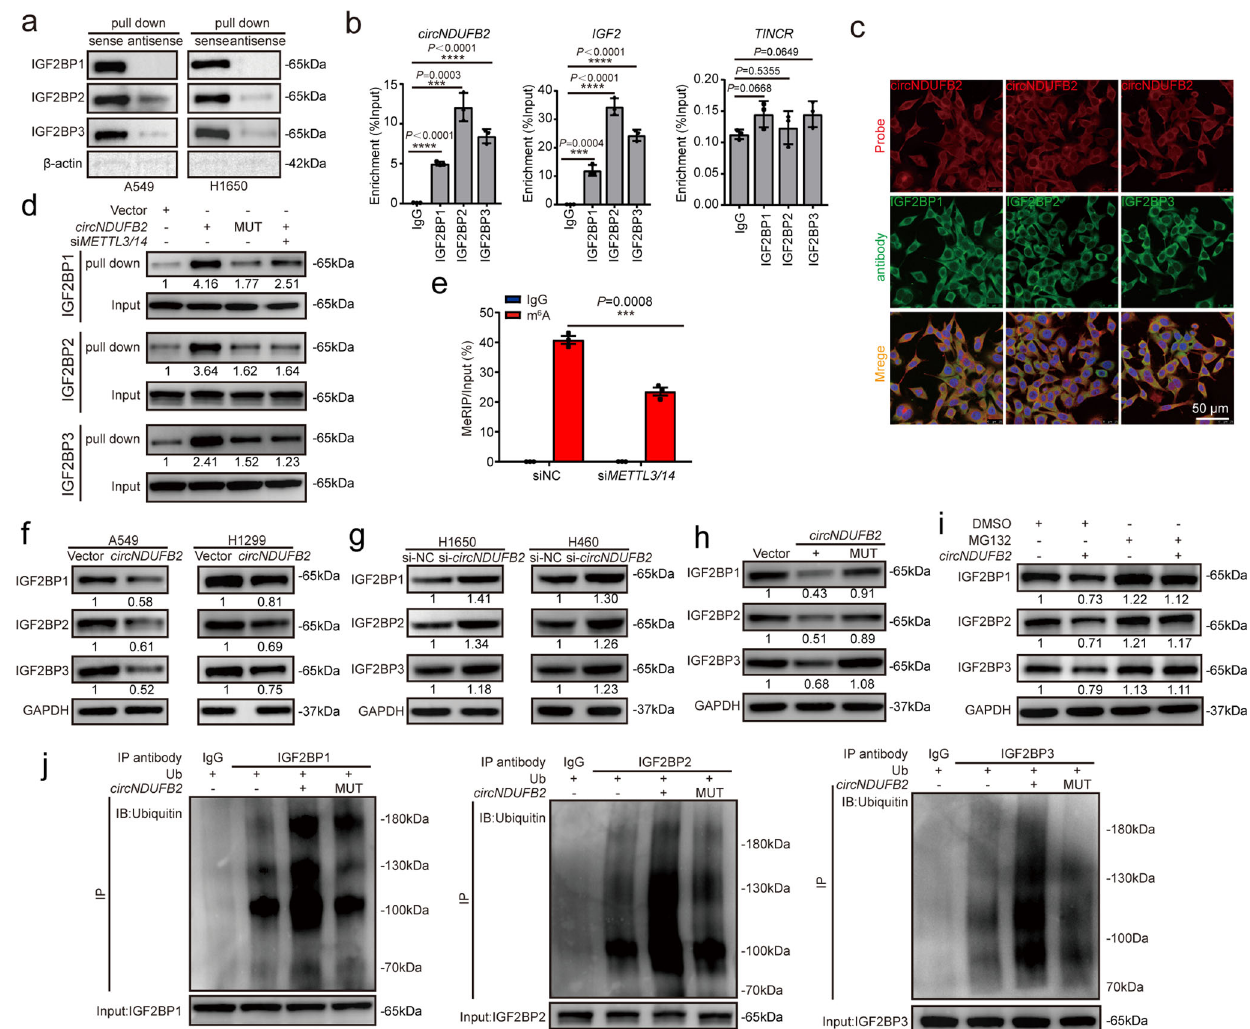
Fig. 3 circNDUFB2 physically interacts with IGF2BPs and promotes ubiquitin/proteasome-mediated degradation of IGF2BPs. a Interaction of IGF2BP1, IGF2BP2, and IGF2BP3 with circNDUFB2 . β -ACTIN was used as a negative control. b Analysis for circNDUFB2 enrichment. RIP assay was performed using the indicated antibodies in A549 cells. IGF2 was used as a positive control and TINCR was used as a negative control. n = 3 biologically independent samples. c Co-localization of circNDUFB2 (red) with IGF2BP proteins (green), respectively, in A549 cells. Scale bar = 50 μ m. d RNA pull-down assays detected the interaction between circNDUFB2 and IGF2BP proteins in the indicated group. e Gene-speci fi c m 6 A qRT-PCR assay detected m 6 A modi fi cation of circNDUFB2 in A549 cells with or without METTL3/14 knockdown. n = 3 biologically independent samples. f , g Protein levels of IGF2BPs in NSCLC cells with circNDUFB2 overexpression ( f ) or knockdown ( g ), respectively. h Protein levels of IGF2BPs in A549 cells with vector, circNDUFB2 , or circNDUFB2